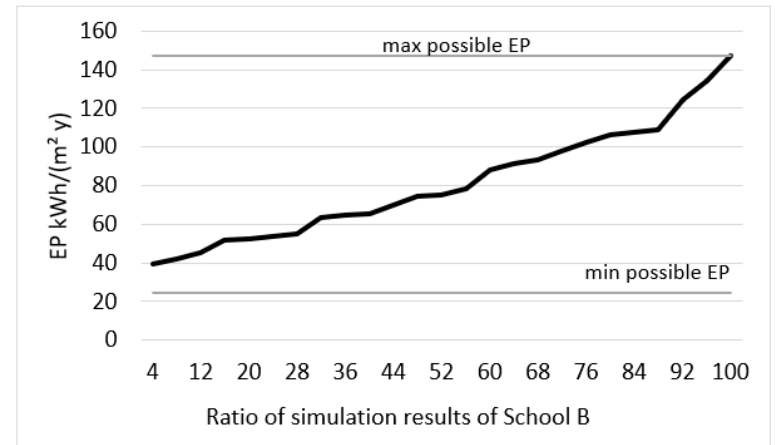
Figure 2. EP results from 25 simulations for Schools S, N and B. The simulations were varied by using randomly chosen combinations of user-related input data, based on the data presented in Table 3. Constant values of other input data in the simulation models were used. Thermal energy was used for calculating E SH and E DHW . The area m 2 in the figures refers to A temp .